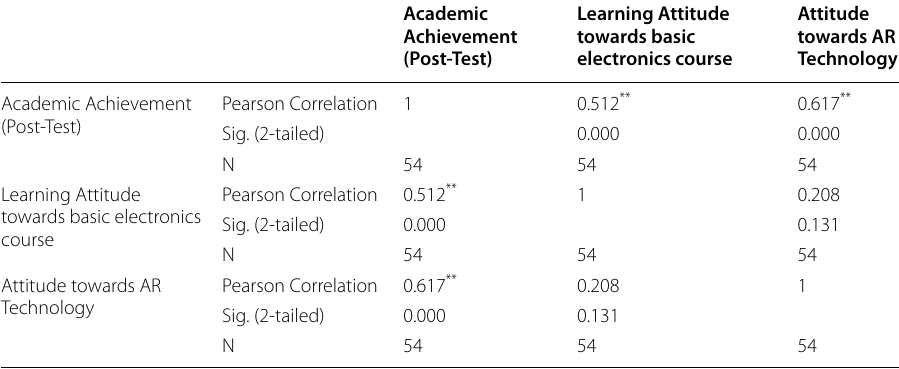
Table 6 Correlations between Academic Achievement, Learning Attitude towards the basic electronics course and Attitude towards AR